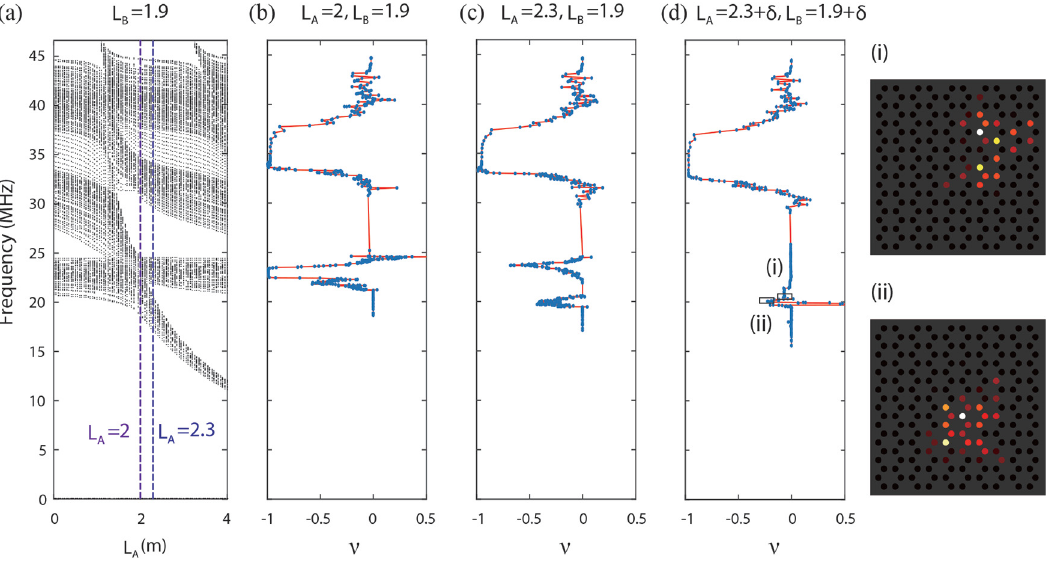
Fig. 4. (a) Energy spectrum as a function of L A . The L B is fi xed at L B = 1.9. (b) – (d) The local Chern number curves for the three cases: (b) L A =2, L B =1.9, (c) L A = 2.3, L B = 1.9, (d) L A =2.3 + d , L B = 1.9+ d